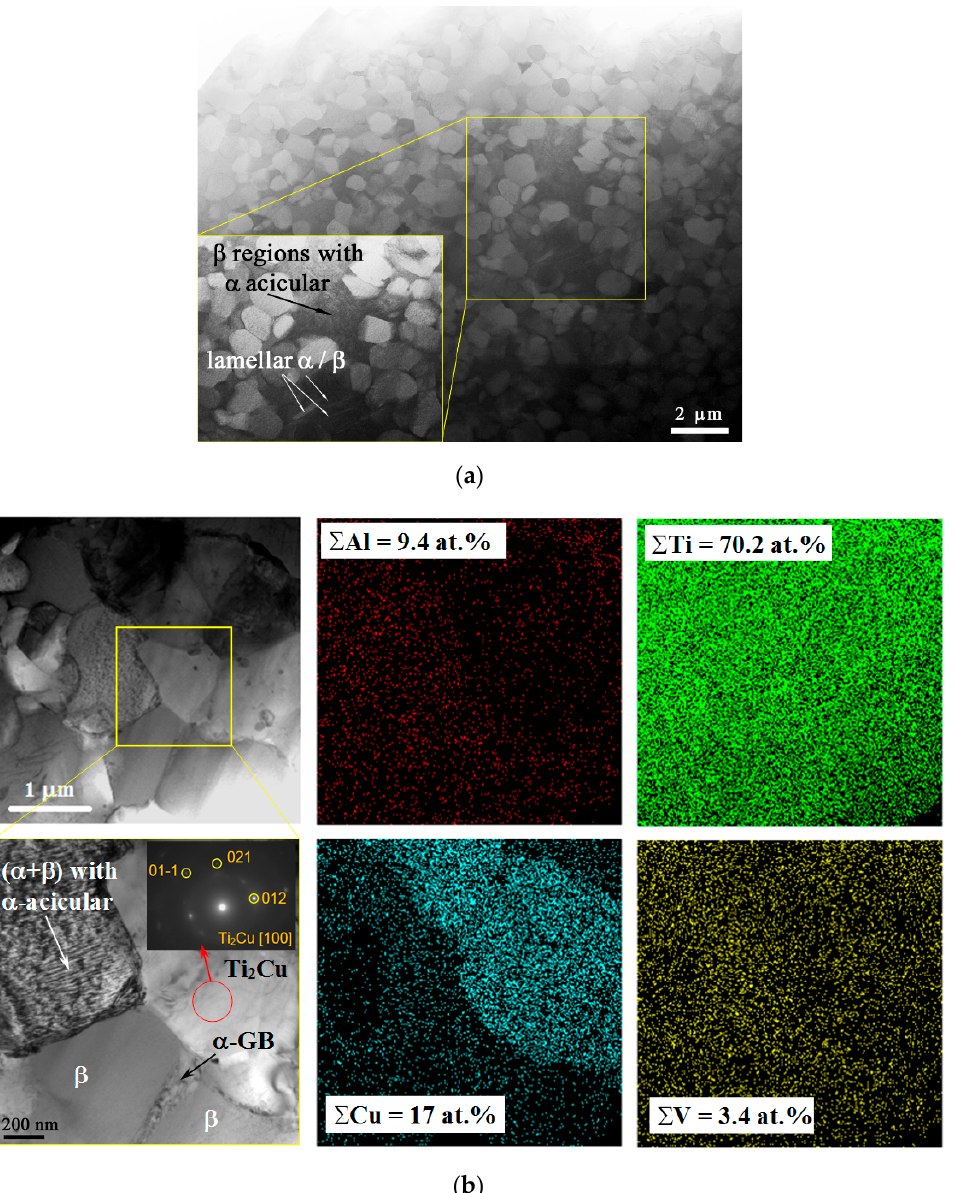
Figure 7. TEM bright-field image of grain microstructures of 6-pass FSPed Ti6Al4V/Cu ( a ), Ti 2 Cu IMC area with the enlarged image of the IMC grain, SAED pattern and corresponding EDS element distribution maps ( b ).